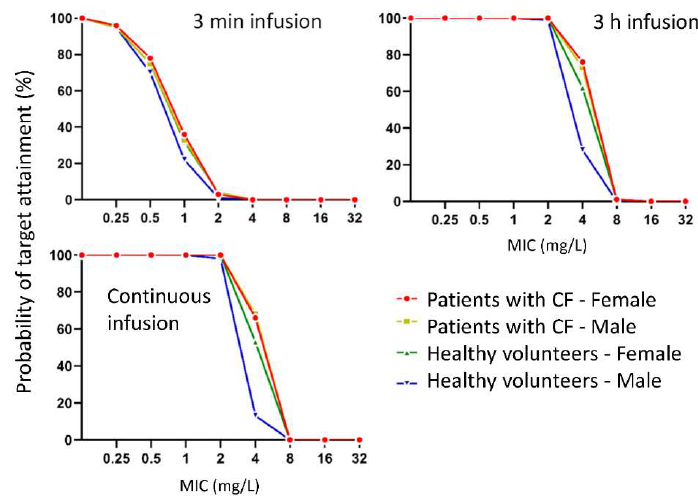
Figure 4. Probability of target attainment plot over a range of minimal inhibitory concentrations (MICs) for the bacteriostasis targets (40% f T > MIC ) in female and male patients with CF and healthy volunteers. A probability of target attainment of 90% was defined as the pharmacokinetic / pharmacodynamic (PK / PD) breakpoint. Table 5. PK / PD breakpoints (i.e., the highest MICs [in mg / L] with a probability of target attainment of at least 90%) for three cefotiam dosage regimens in patients with CF and healthy volunteers. All simulated regimens used a daily dose of 3000 mg cefotiam (not adjusted by body weight).